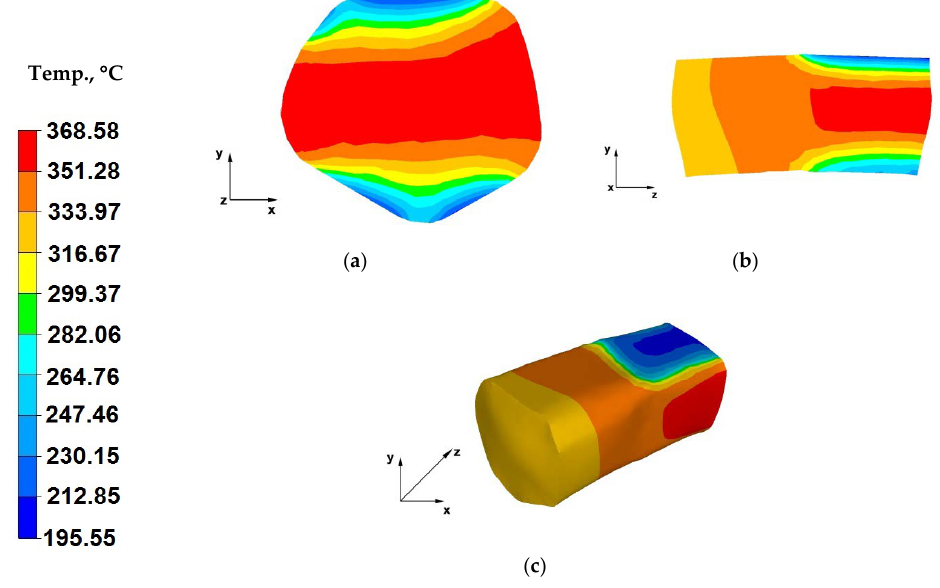
Figure 14. ( a ) Temperature distribution over the cross-section of an AZ91 alloy forging deformed within the fourth pass, with a relative reduction of 40%, in trapezoid-rhombic dies, after a 90° turning of the forging; ( b ) Temperature distribution over the longitudinal-section of an AZ91 alloy forging deformed within the fourth pass, with a relative reduction of 40%, in trapezoid-rhombic dies, after a 90° turning of the forging; ( c ) Axonometric view of the temperature distribution over the surface of an AZ91 alloy forged within the fourth forging pass, with a relative reduction of 40%, in trapezoid-rhombic dies, after a 90° turning of the forging.